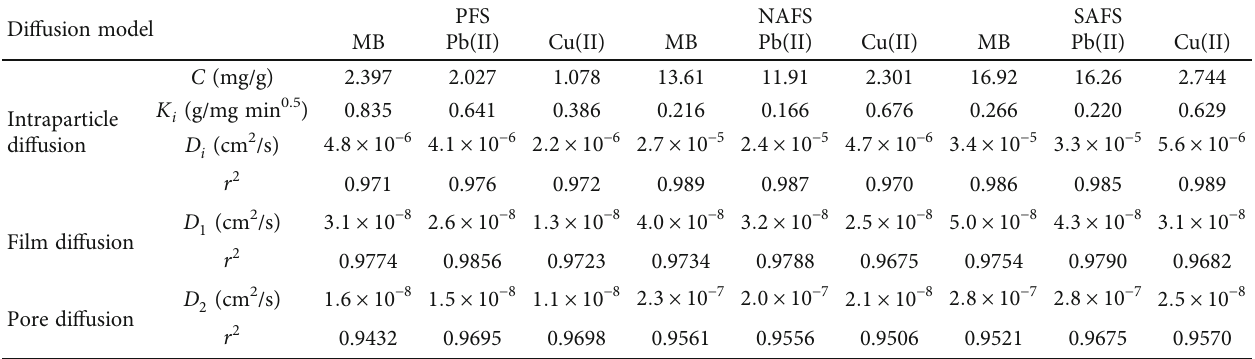
Table 6 were estimated from the data of temperature e ff ect.